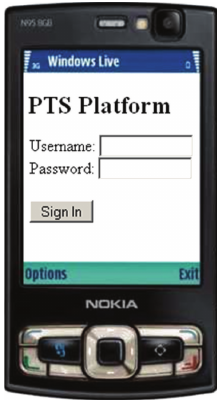
Figure 5: once assigned boundary and initial